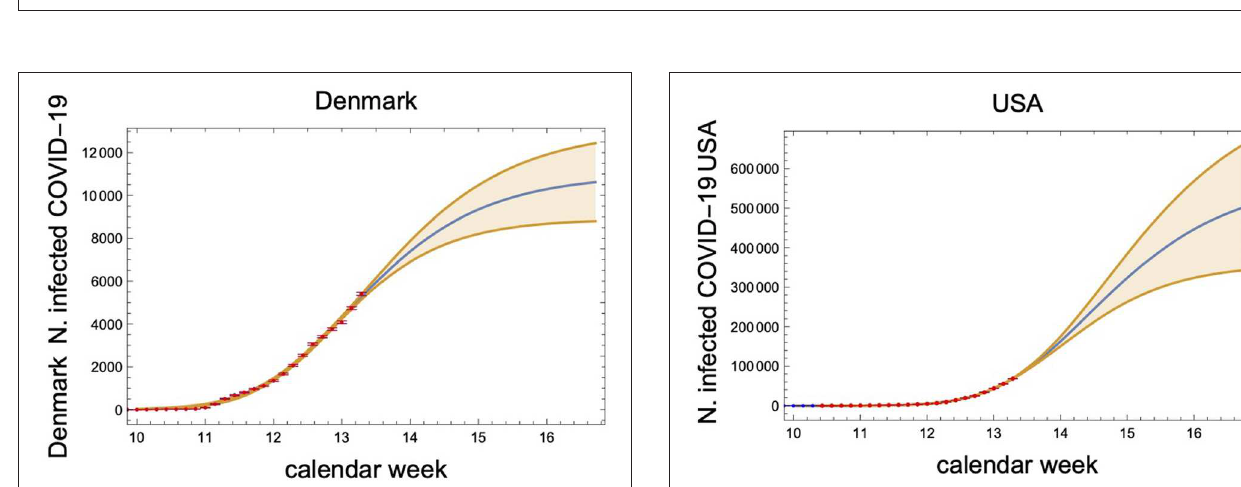
FIGURE 11 | Fit parameters to Italy COVID-19 data as function of time. (Left) a ( t ). (Center) b ( t ). (Right) γ ( t ). The errors correspond to 90% confidence level.